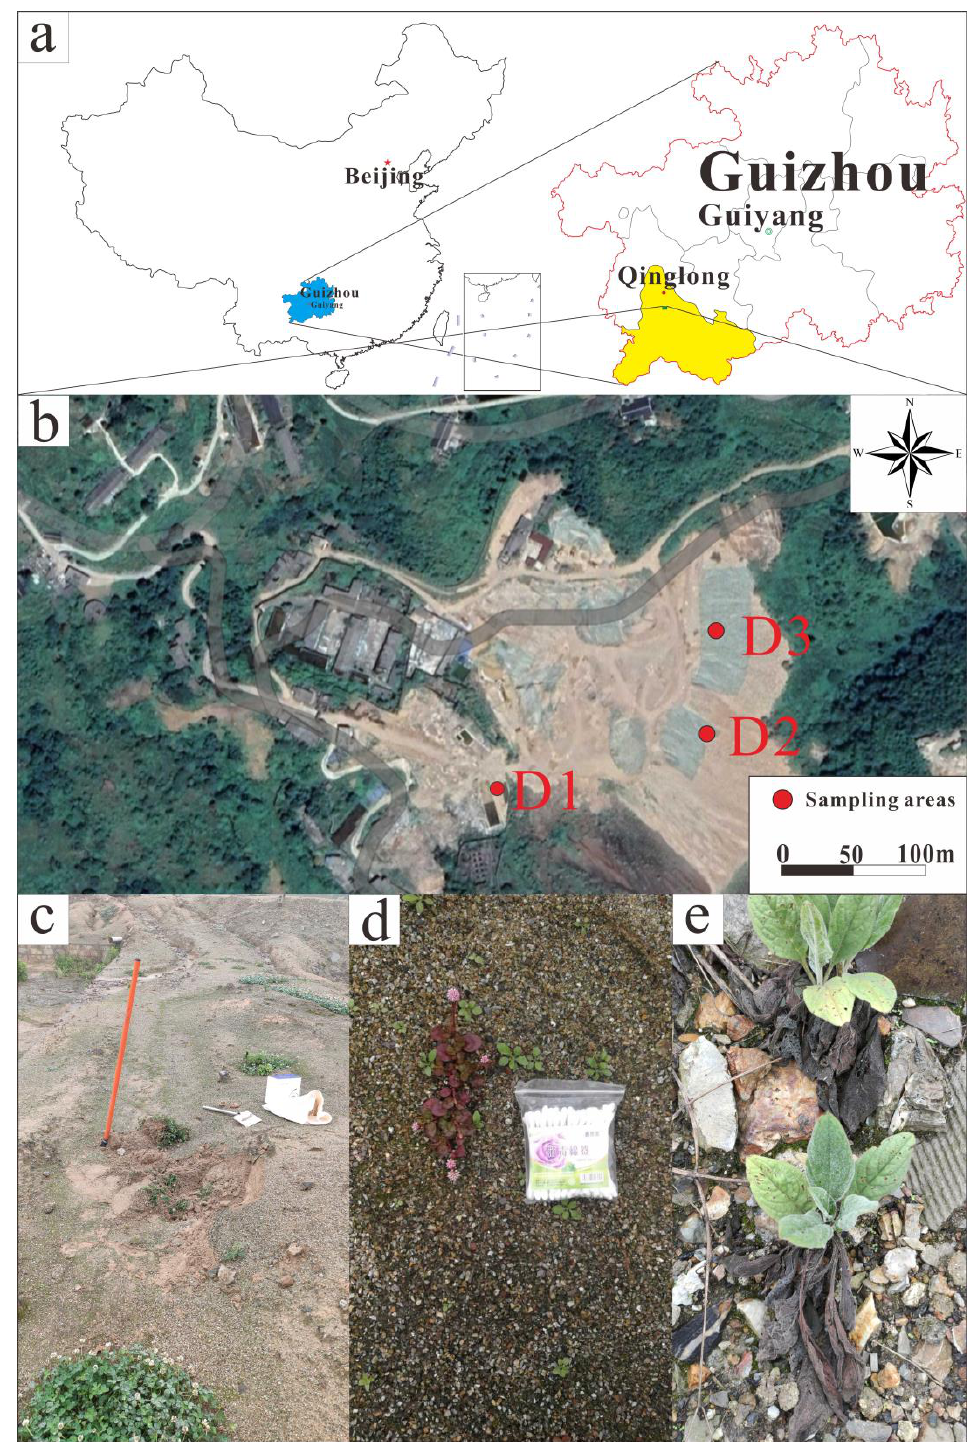
Figure 1. ( a ): Geographical location map of Qinglong Antimony Mine; ( b ): Distribution map of sampling points, where D1 is the tailing area, D2 is the slag area, and D3 is the waste rock area; ( c ): Tailing and Trifolium repens L.; ( d ): Slag and Polygonum capitatum ; ( e ): Waste rock and Cynoglossumlanceolatum Forssk.